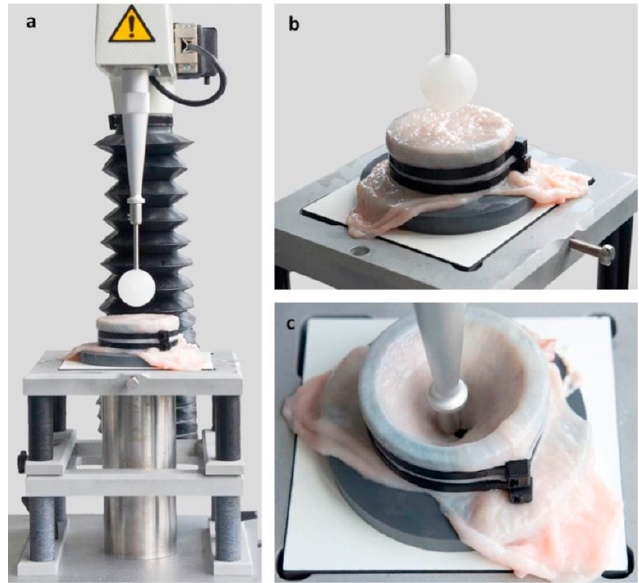
( c ) Shows the test upon failure of the material with the ball that advanced through the tissue rup- turing it. Figure obtained with permission from